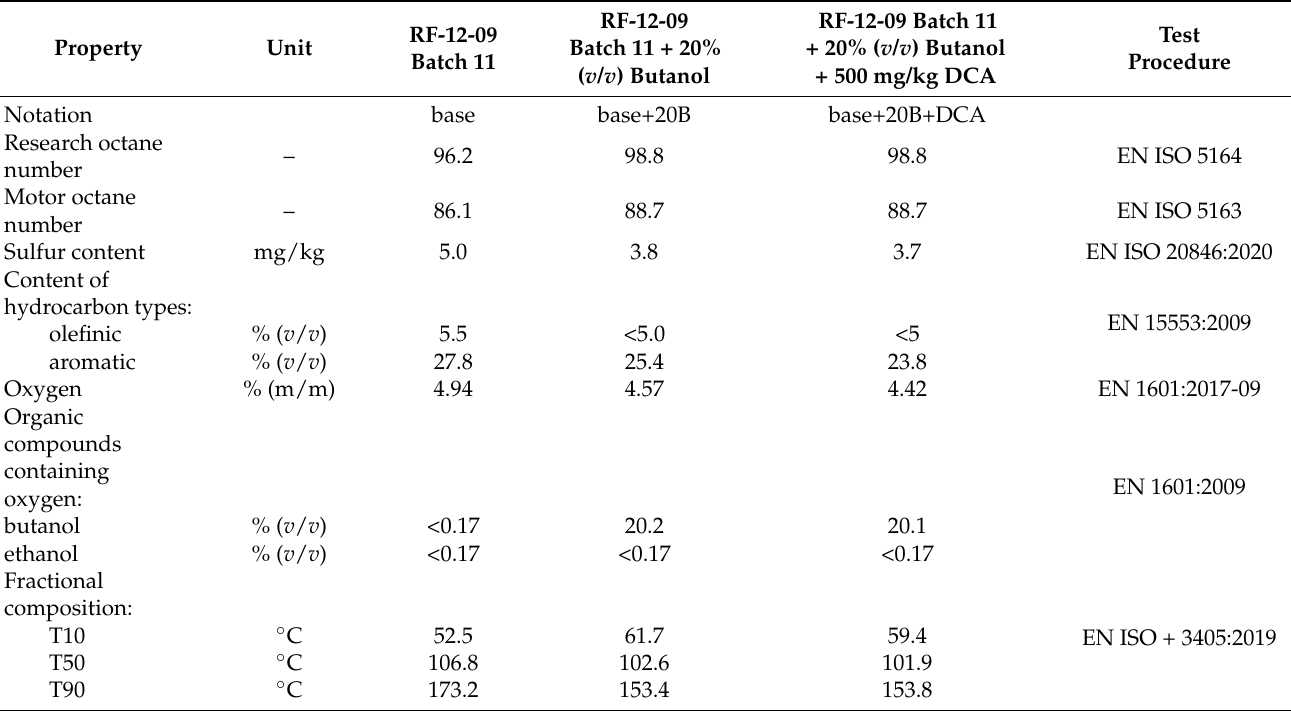
Table 2. Physicochemical properties of gasoline samples prepared for engine